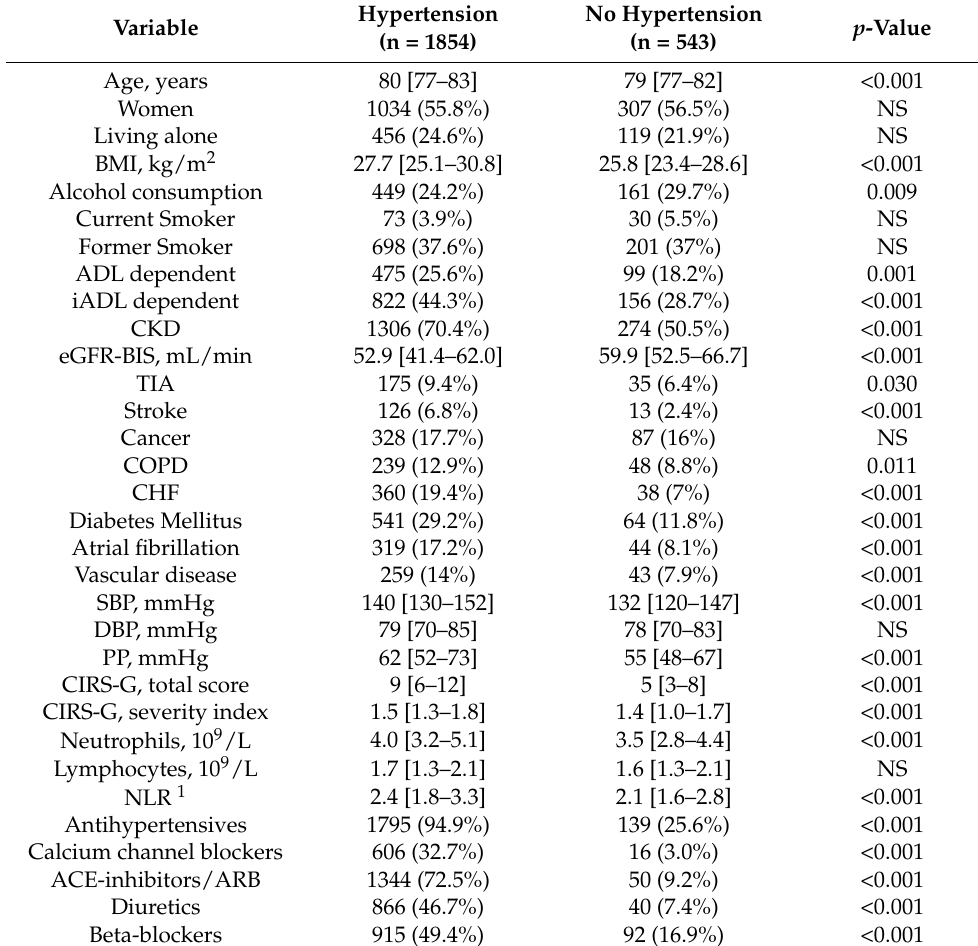
Table 1. Overall sample description in individuals with and without